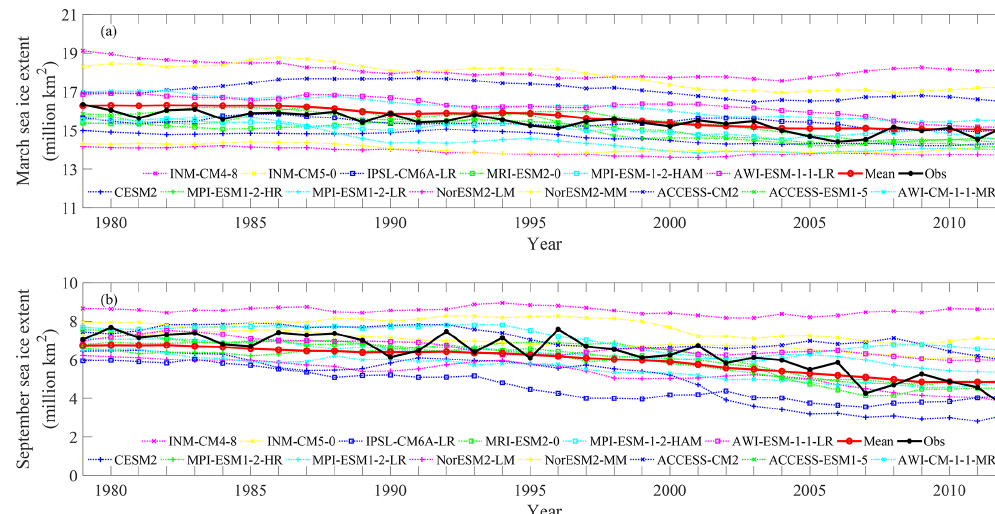
Figure 1. The observations and five-point moving averages of sea ice extent in March and September during 1979–2012.